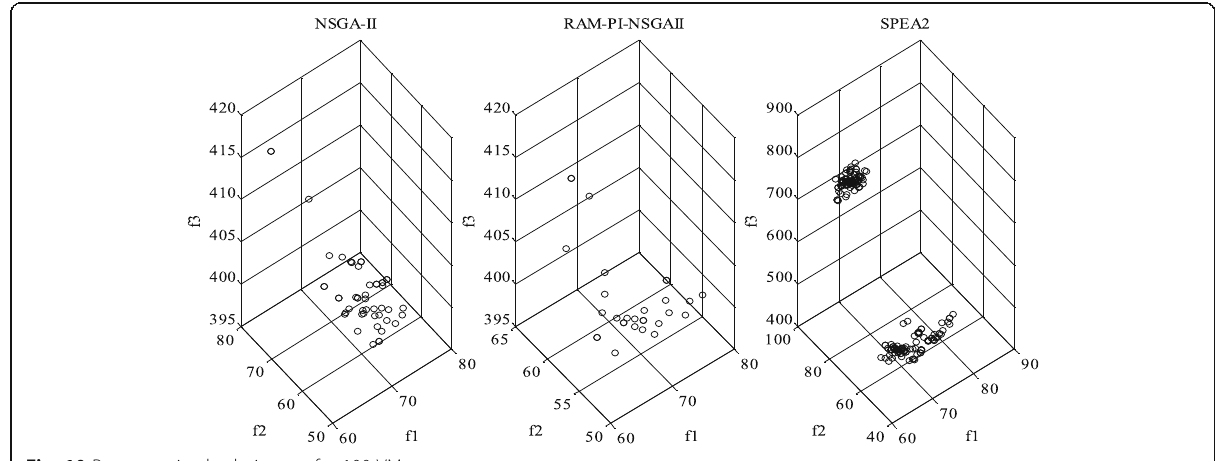
Fig. 10 Pareto optimal solution set for 100 VM requests